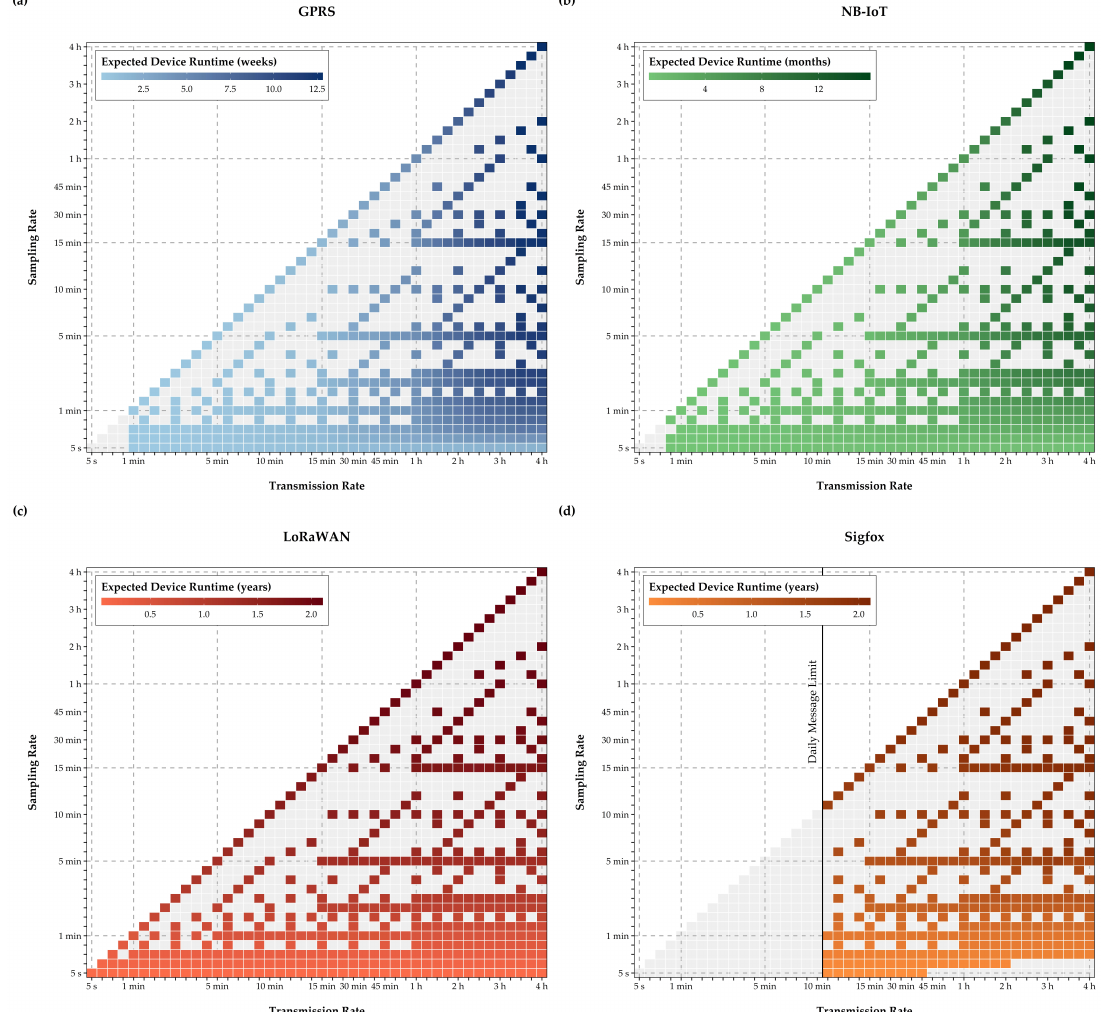
Figure 9. Expected EPMD runtime with a 3700 mWh battery ( a – d